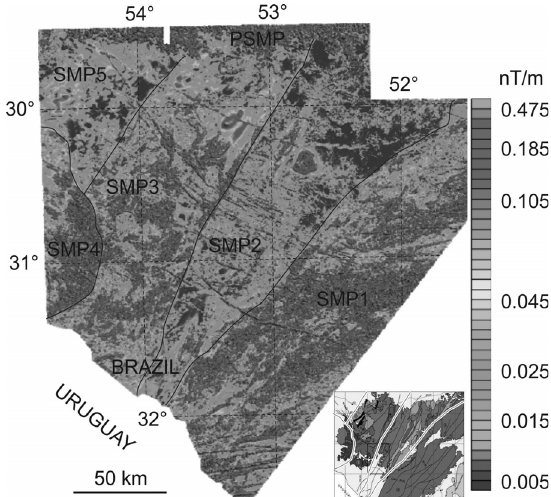
Figure 10 - Map of the analytic signal of the aeromagnetic anomaly of the Sul-Riograndense Shield. Indication of shallow magnetic provinces in the Sul-Riograndense Shield (e.g., SMP1). PSMP = Paraná shallow magnetic province. For interpretation of the references to color in this fi gure legend, the reader is referred to the web version of this